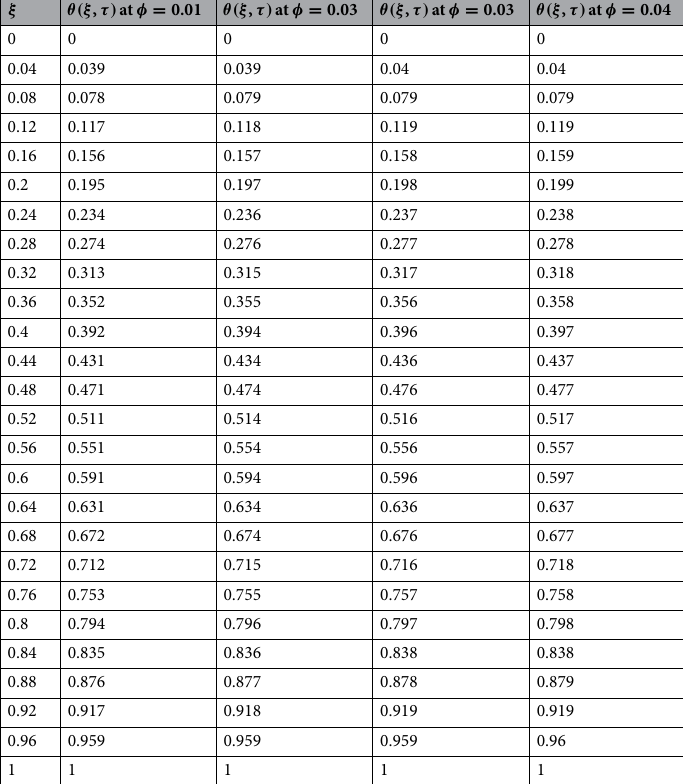
Table 10. Variations in temperature profile against ξ if f (τ) = 1 for different values of φ .